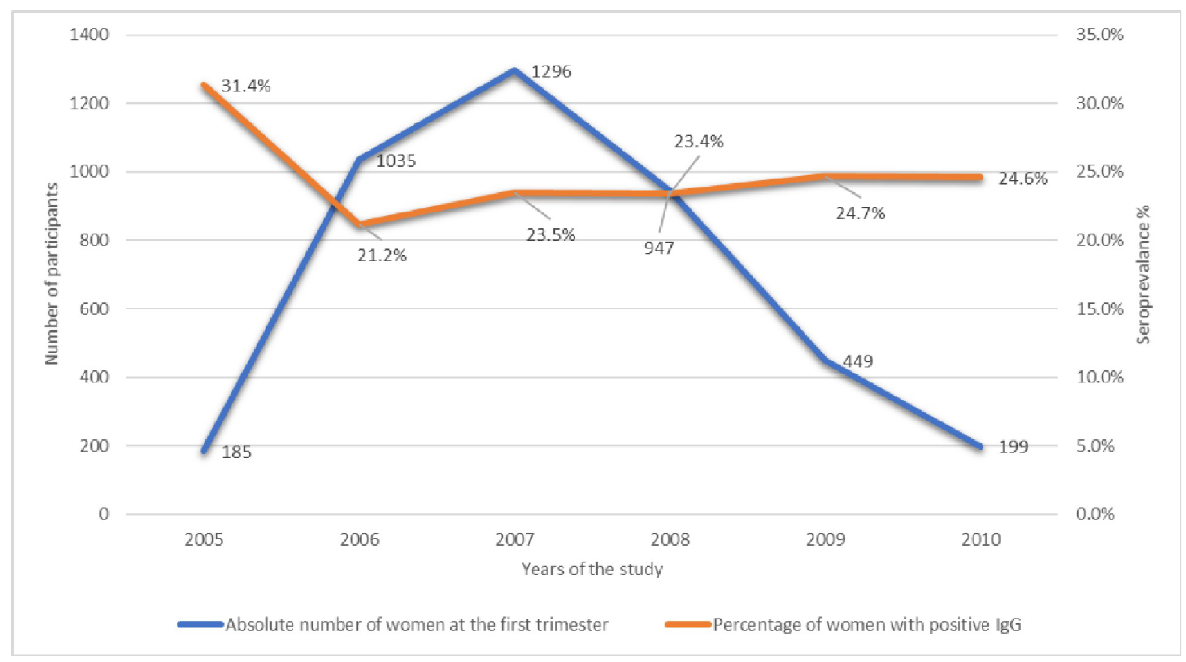
Fig 2. Seroprevalence of CMV in the first trimester of pregnancy over